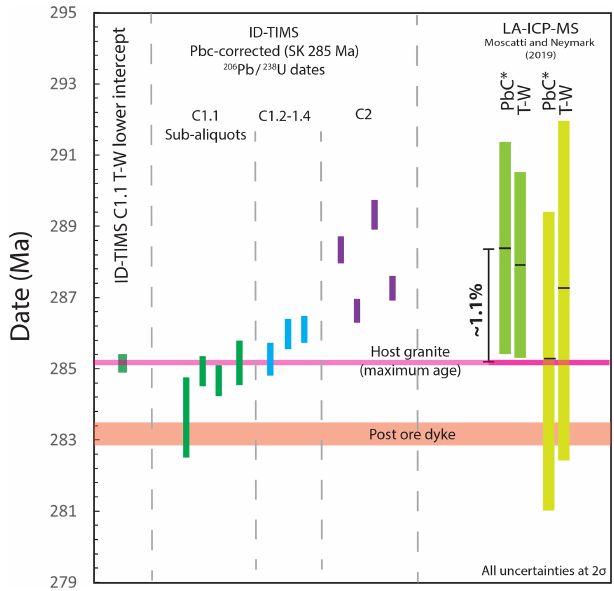
Figure 10. The effects of using a correction for Pbc on the 206 Pb / 238 U dates of single analyses of cassiterite; in this case a model Pbc value at 285Ma (Stacey and Kramers, 1975) was used. Data are shown relative to the freely regressed ID-TIMS lower in- tercept of C1.1 that shows excellent agreement with the host gran- ite age. Pbc-corrected dates range from being in good agreement with the age constraints to being offset by ∼ 4Myr relative to the maximum possible age of cassiterite defined by zircon dates for the granite. The samples analysed in a previous LA-ICP-MS study from Cligga Head (Moscati and Neymark, 2019) illustrate similar mag- nitudes, and the direction of offset can be observed in both the T– W regressions. Despite the agreement of the Pbc-corrected (Pbc*) weighted-mean 206 Pb / 238 U date 290Ma (Stacey and Kramers, 1975) of one sample, this approach to data interpretation is invalid; see the text for